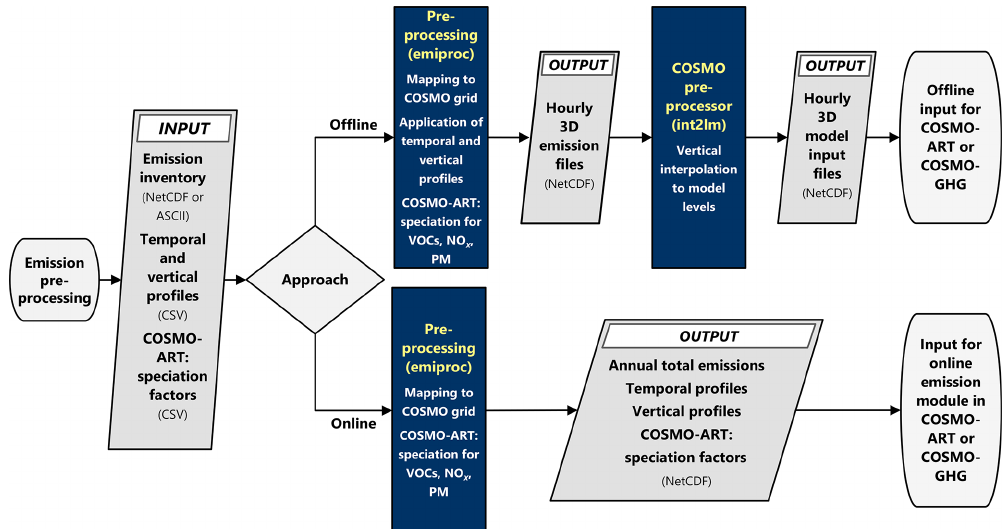
Figure 1. Flow chart of the emission pre-processing for both offline and online approaches as implemented in COSMO-GHG and COMSO- ART. Dark gray parallelograms represent data (with input or output indicated). Blue rectangles are processing scripts. Start and end points are represented by